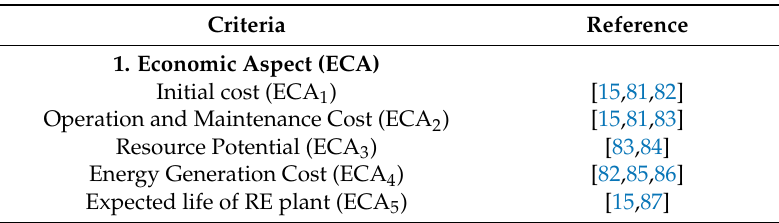
Table 7. Criteria refined by the